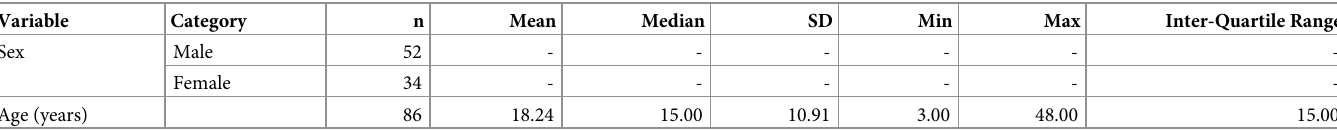
Table 2. Demographic variables.